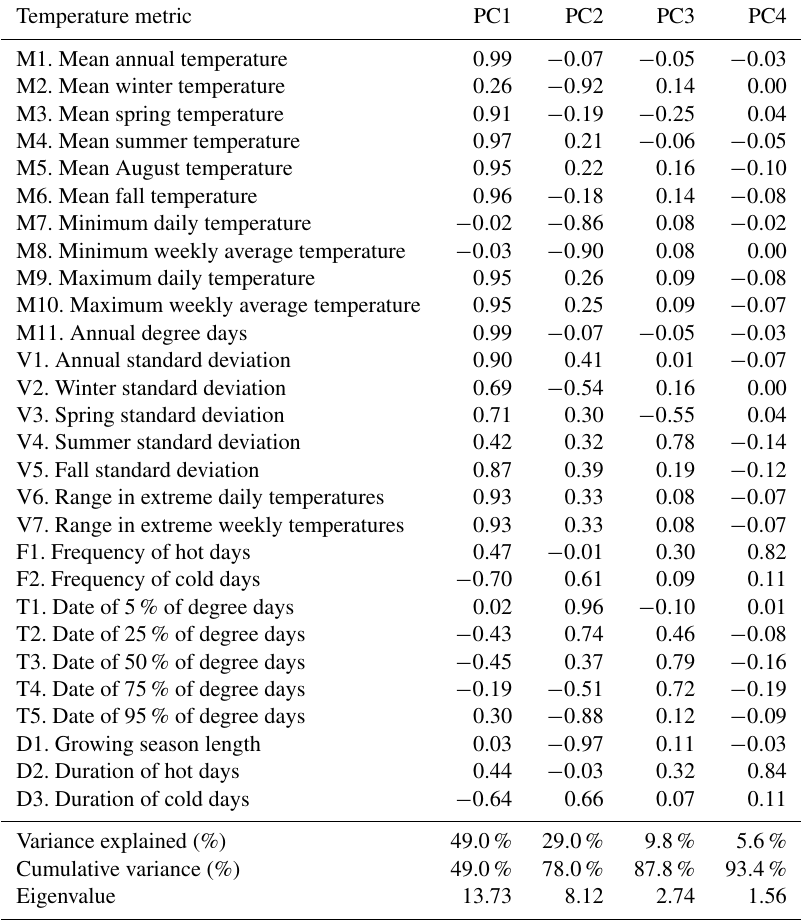
Table 4. Loadings of 28 temperature metrics on the first four principal components in a PCA of annual temperature records from mountain river networks in the northwestern United States.